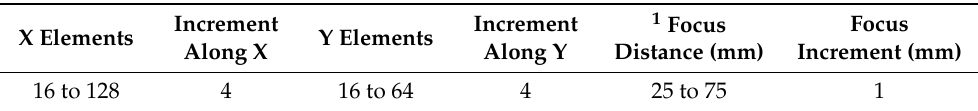
Table 2. Range of ultrasonic transducer elements and focus distances for constant transducer area and